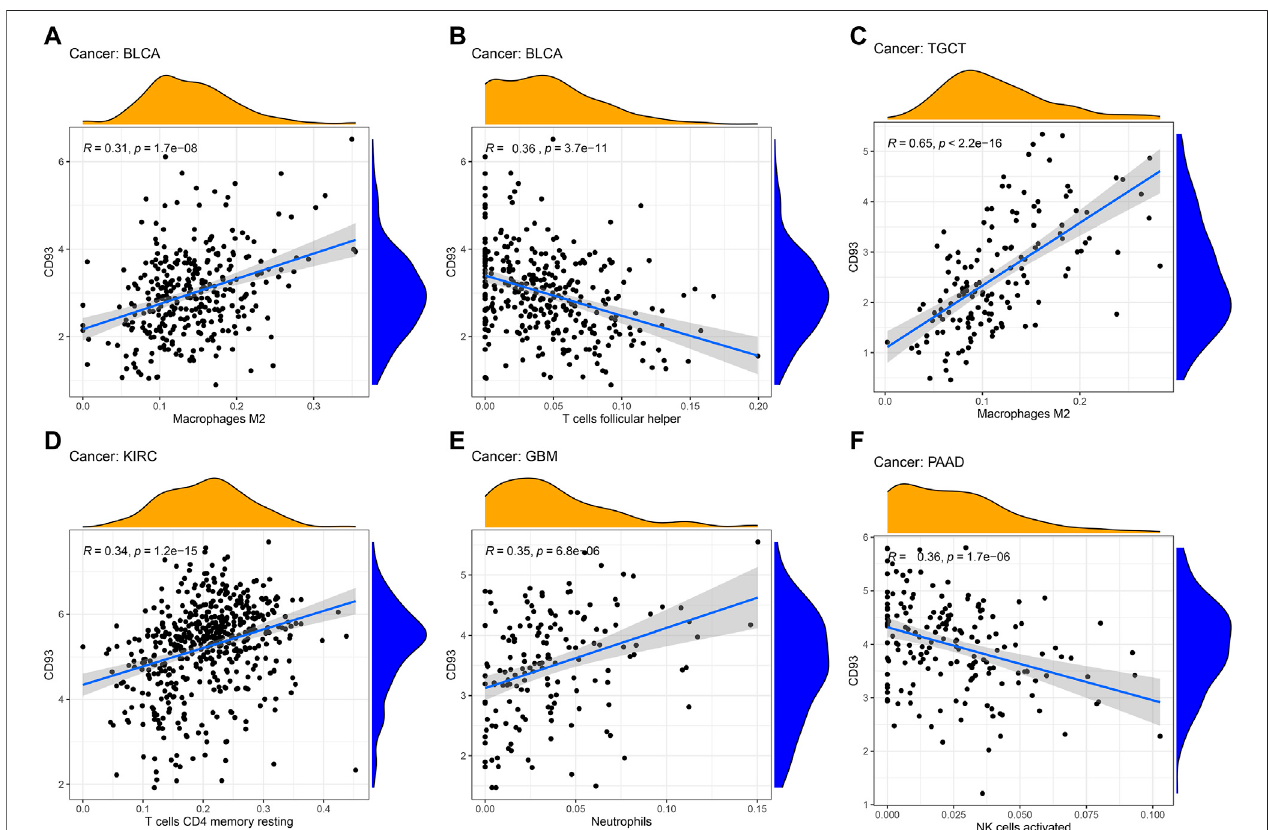
FIGURE 4 | Correlation between CD93 expression and immune cell in fi ltration. (A – F) : The correlation analysis between CD93 expression and immune cell in fi ltration in BLCA, TGCT, KIRC, GBM and